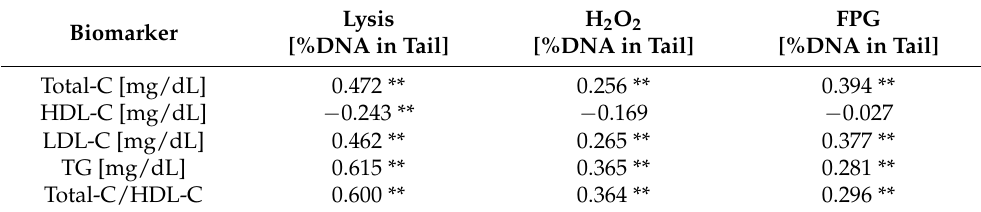
Table 5. Correlations of DNA damage markers with plasma lipid biomarkers at baseline in the Austrian